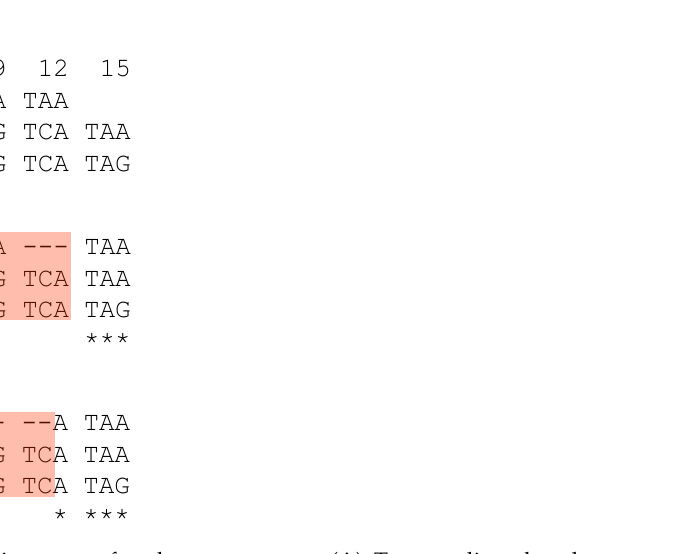
Figure 2. Suboptimal alignment of codon sequences. ( A ) Two unaligned codon sequences. ( B ) Align- ment from codon-based alignment methods. ( C ) A better alignment based on alignment scores.